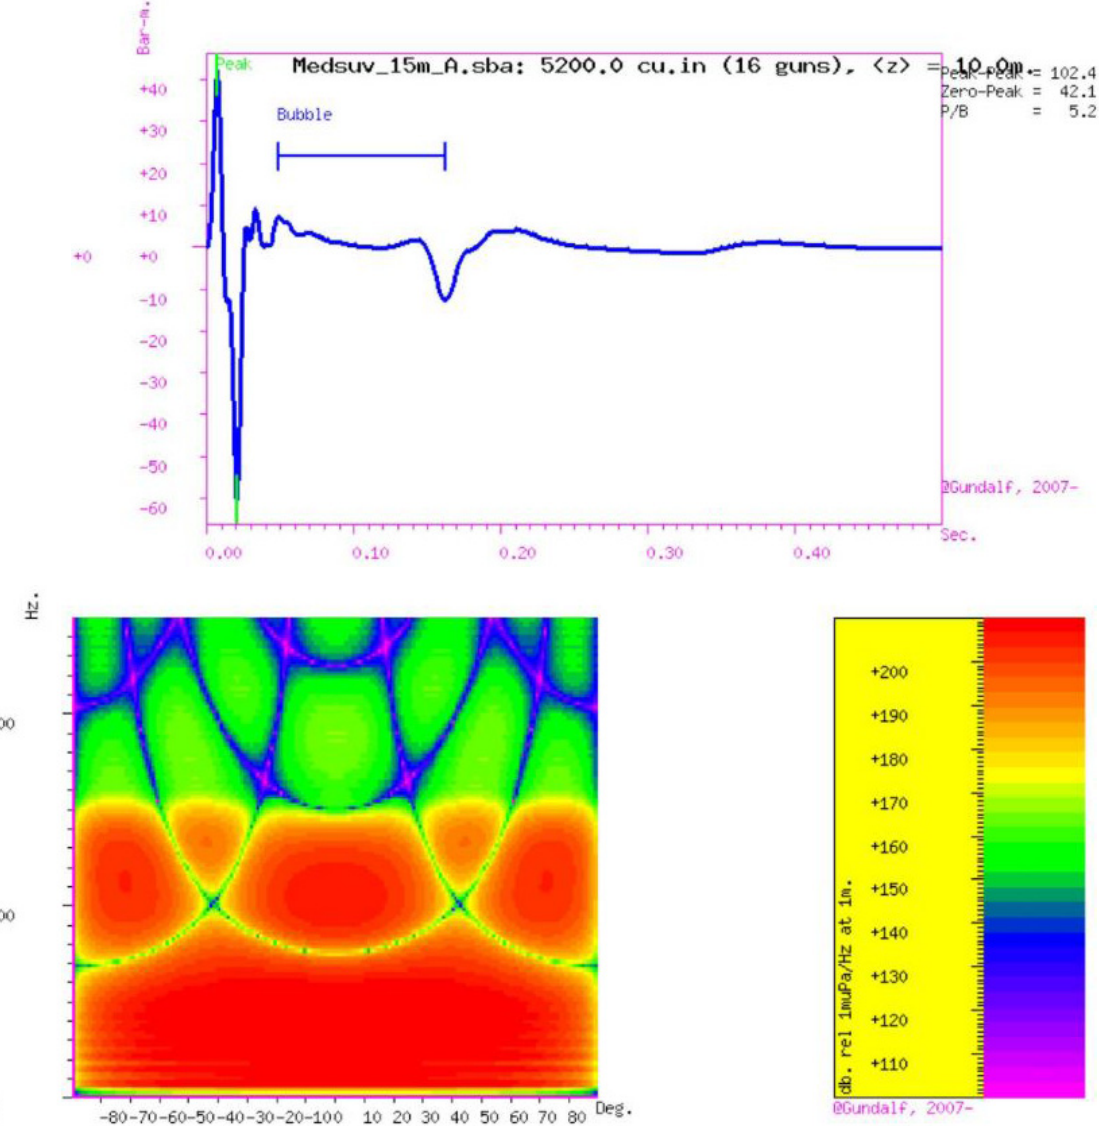
Figure 9. Theoretical pulse of the active air-gun source performed during the WAS campaign in the time and the spatial domain.